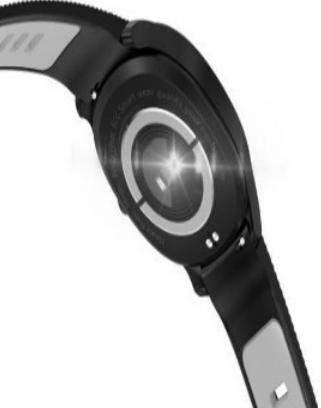
Figure 6. CODOC Patient wrist band with sensor